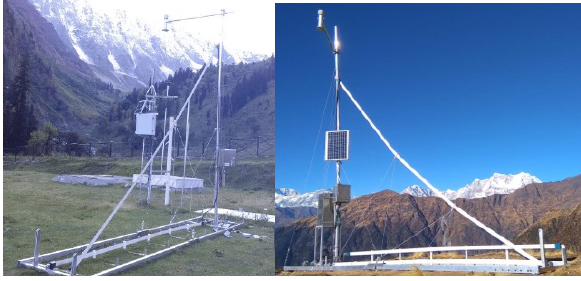
Figure 3. Installed SPA at Dhundi, Manali and Tungnath, UK.